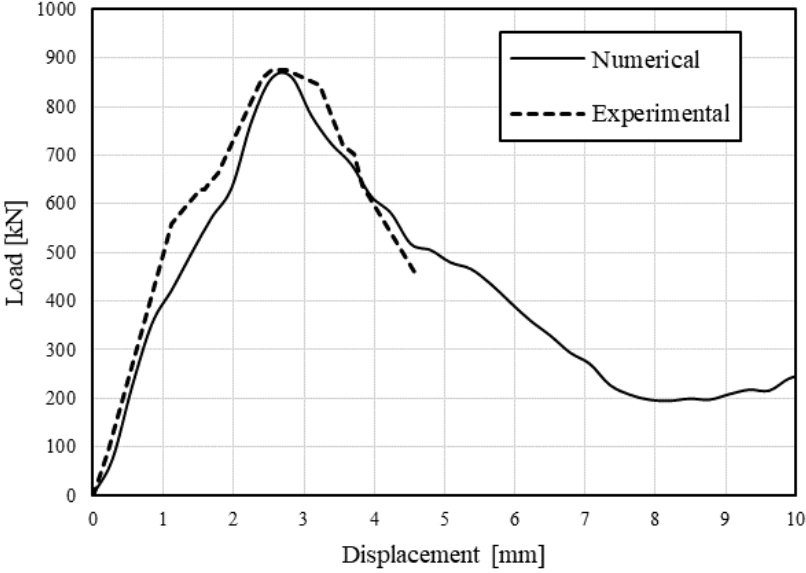
Figure 8. Comparison between numerical and experimental load vs. displacement curves.